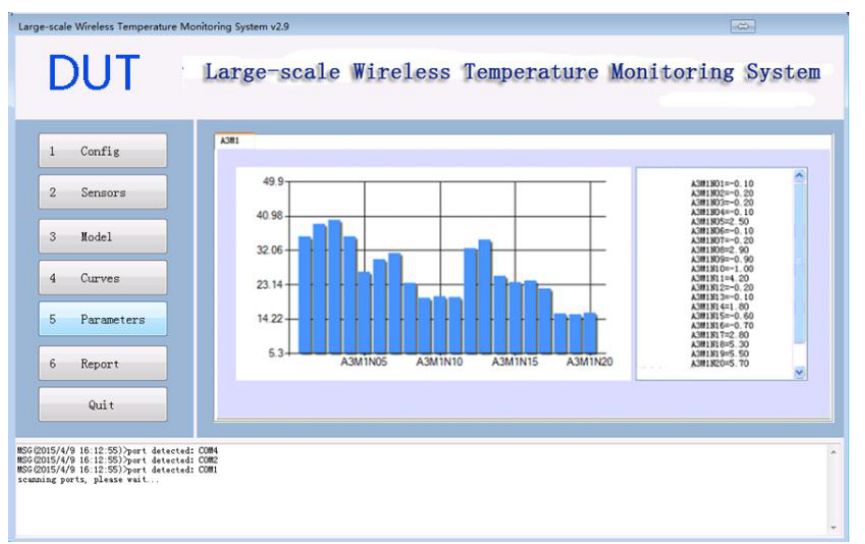
Figure 16. Monitoring Parameters